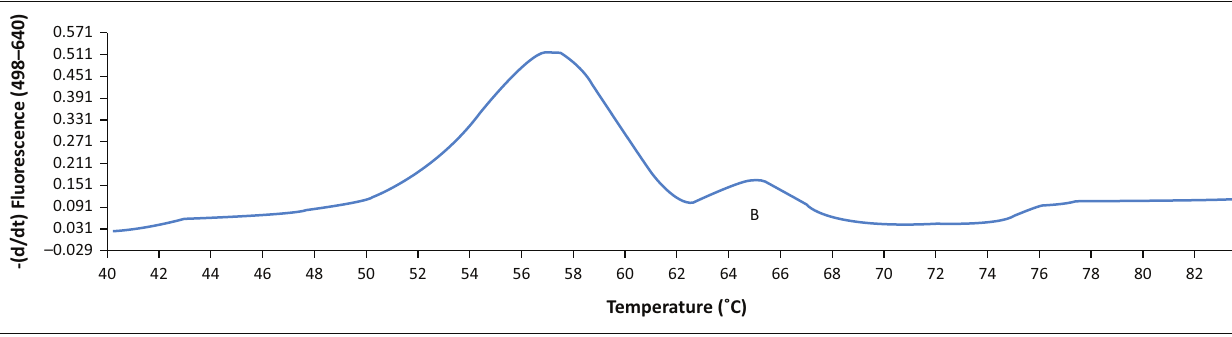
FIGURE 5: Melting peaks for optimised duplex real-time polymerase chain reaction showing stx